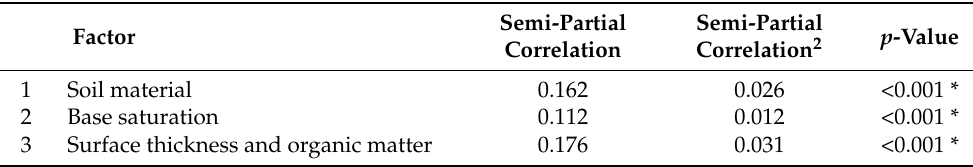
Table 1. Semi-partial correlation and squared semi-partial correlation of Dideriksen soil factors with Dideriksen suitability index values. Factors with zero variance were not included and are marked with a